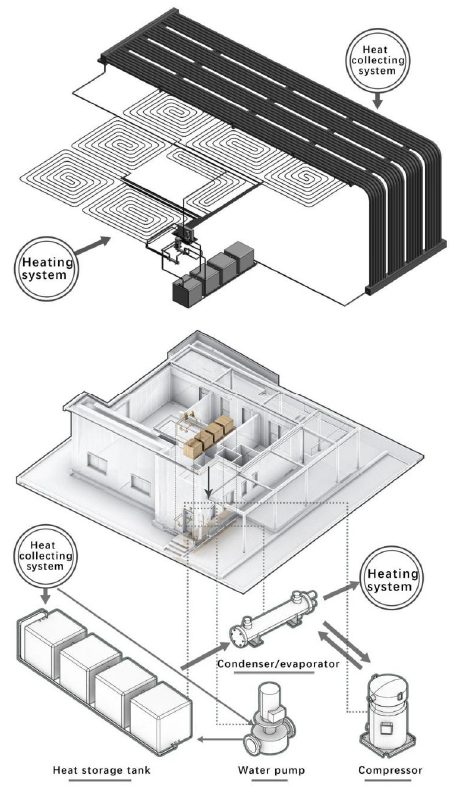
Figure 19. BIM model of central control unit system.